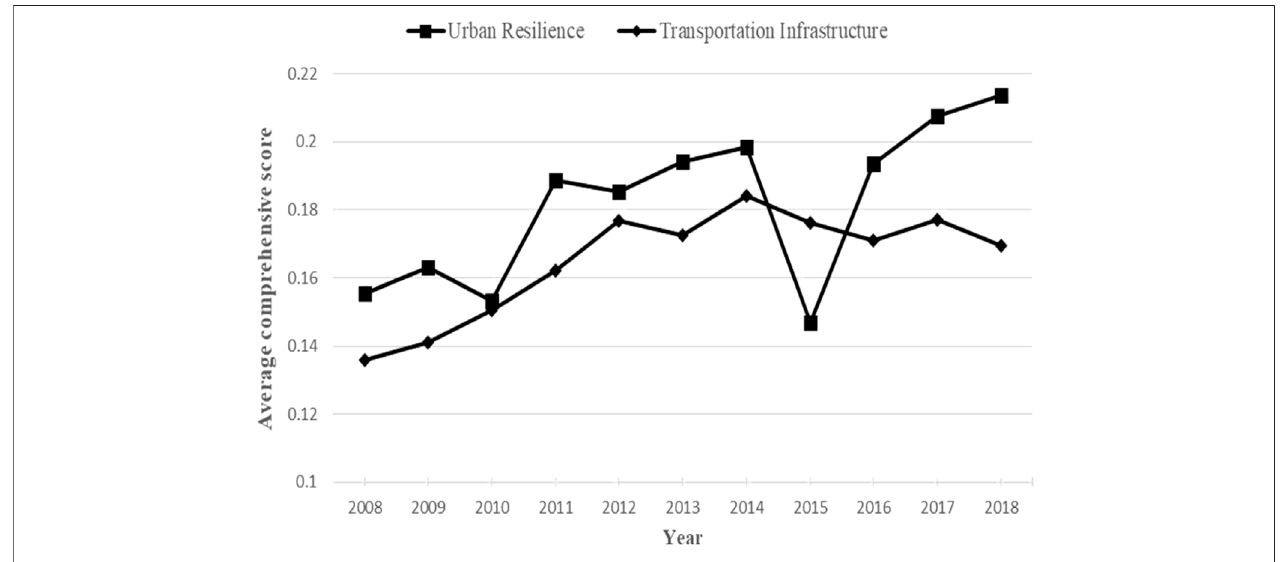
FIGURE 2 | Evolution trend of the average comprehensive score of urban resilience and the transportation infrastructure level in the Yangtze River Delta.